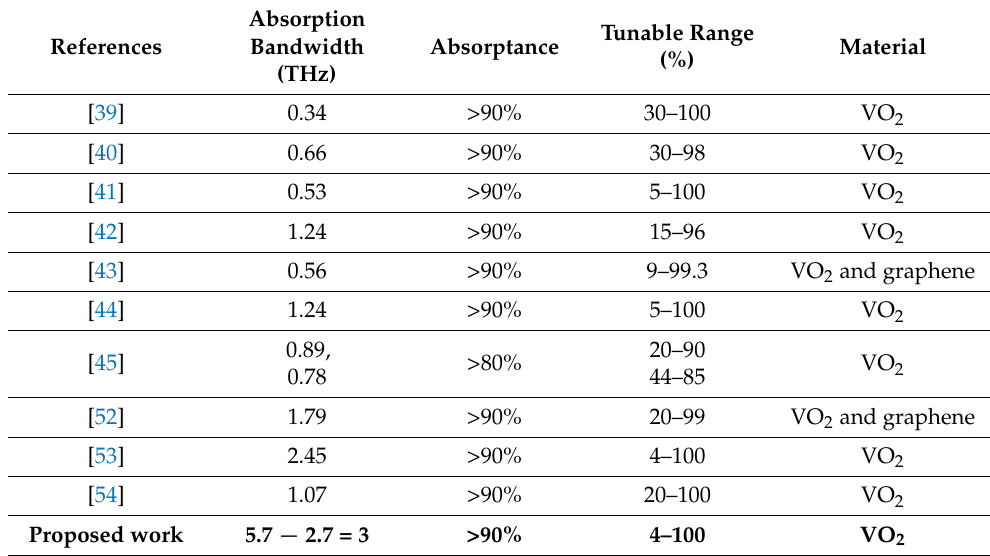
Table 1. Comparison table of the absorption capabilities of various VO 2 -based